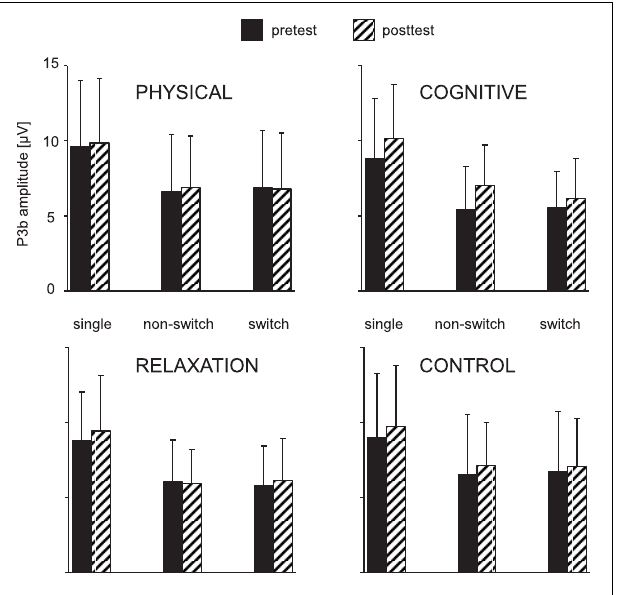
FIGURE 5 | Mean peak amplitudes of the P3b at Pz as a function of the trial type (single task, non-switch and switch trials), session (pre vs. post) and group. The error bars reflect standard deviation (SD).